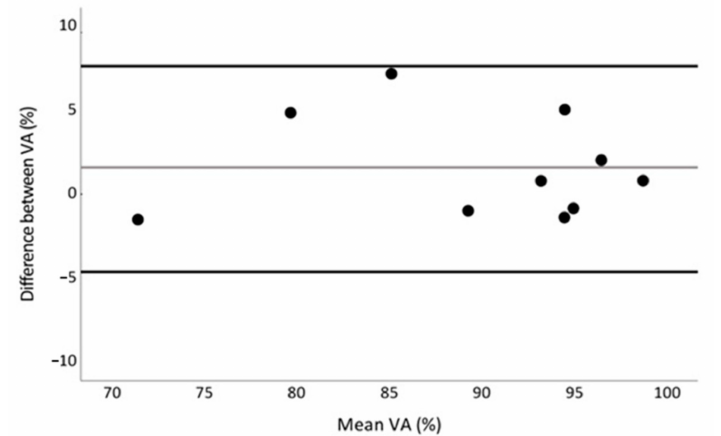
Figure 3. Agreement between the VA assessment by ITT with paired and triple electrical stimuli (Bland–Altman plot). The grey line represents the mean difference (the VA assessed with paired stimuli minus the VA assessed with triple stimuli), and the black lines represent the 95% limits of agreement. Black circles represent value for each